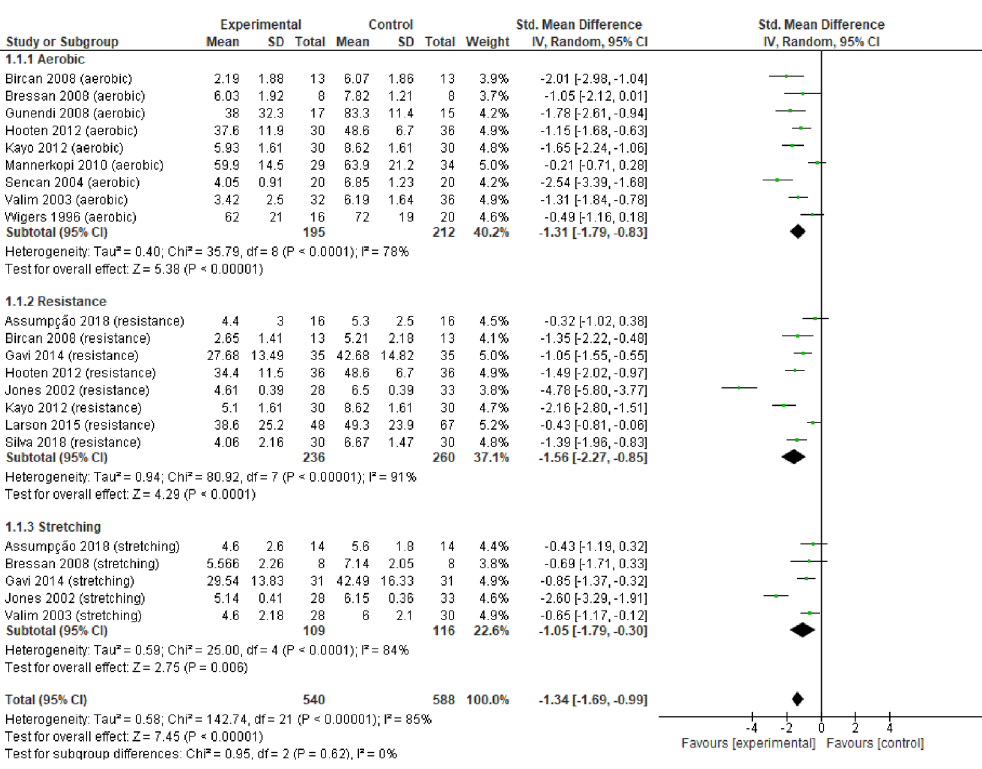
Figure 4. Forest plots showing the effects of training on pain